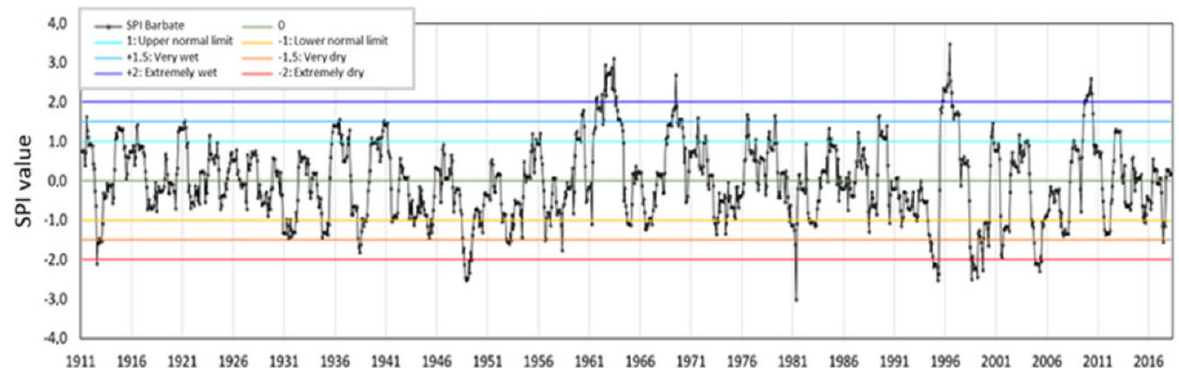
Figure 9. Evolution of the SPI in the Barbate River Basin calculated for a 12-month time window for the period 1910/11–2017/18.